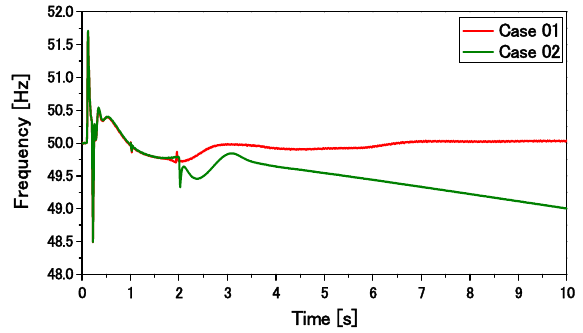
Figure 23. Frequency responses of the power system.